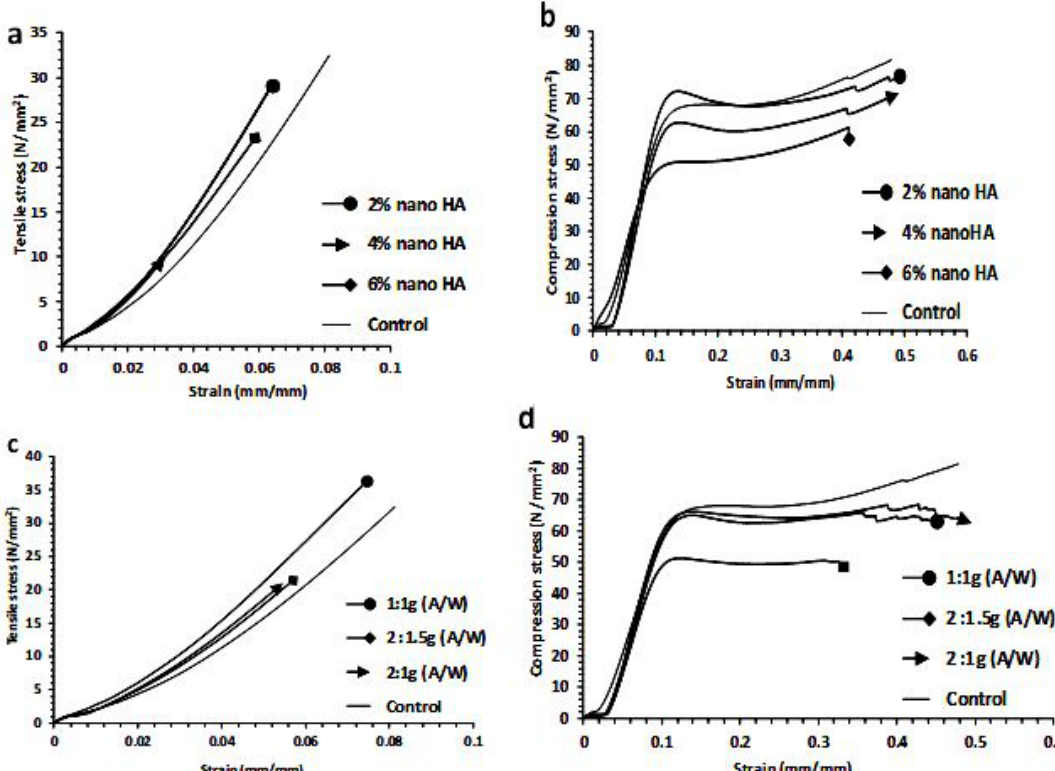
Figure 4. represents the tensile [a, c] and compression [b, d] curves for nano-HAand (A/W) combinations